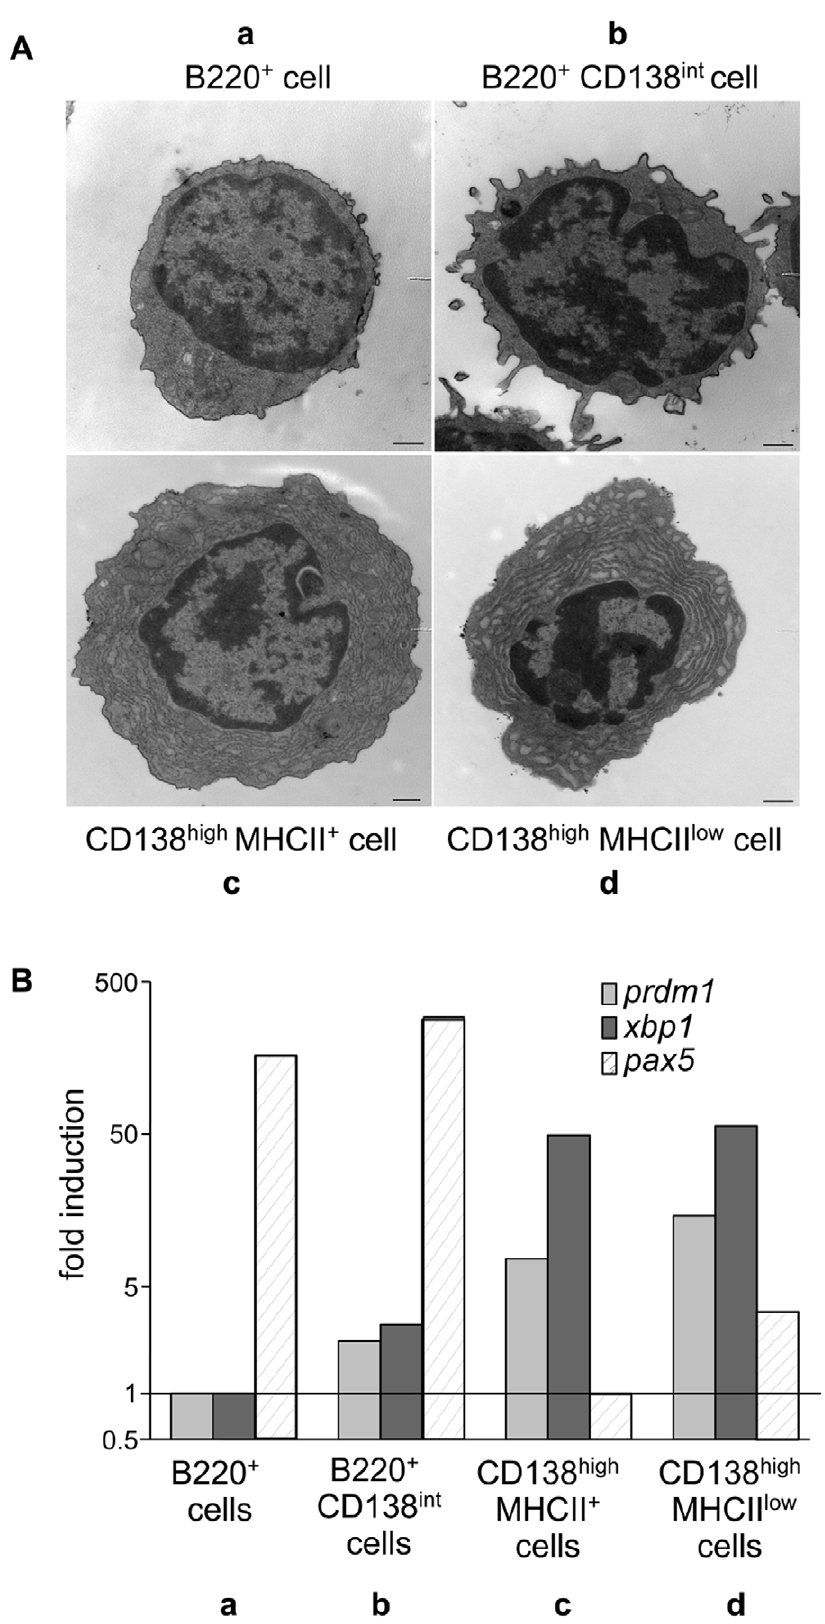
Figure 2. Characteristic ultrastructural morphology and transcription factor expression in cell subsets identified according to B220/ CD138/MHCII expression. A) The four spleen cell subsets (a to d, as described in Figure 1) were sorted by flow cytometry from the spleen of